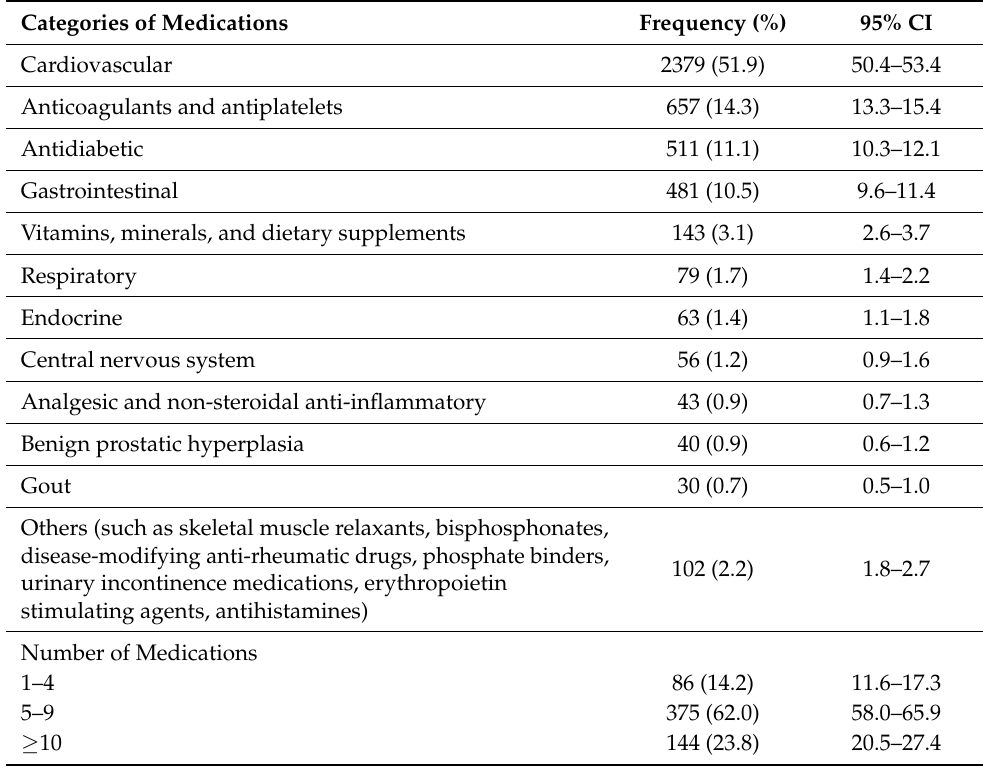
Table 2. Categories of prescribed medications to patients ( n =